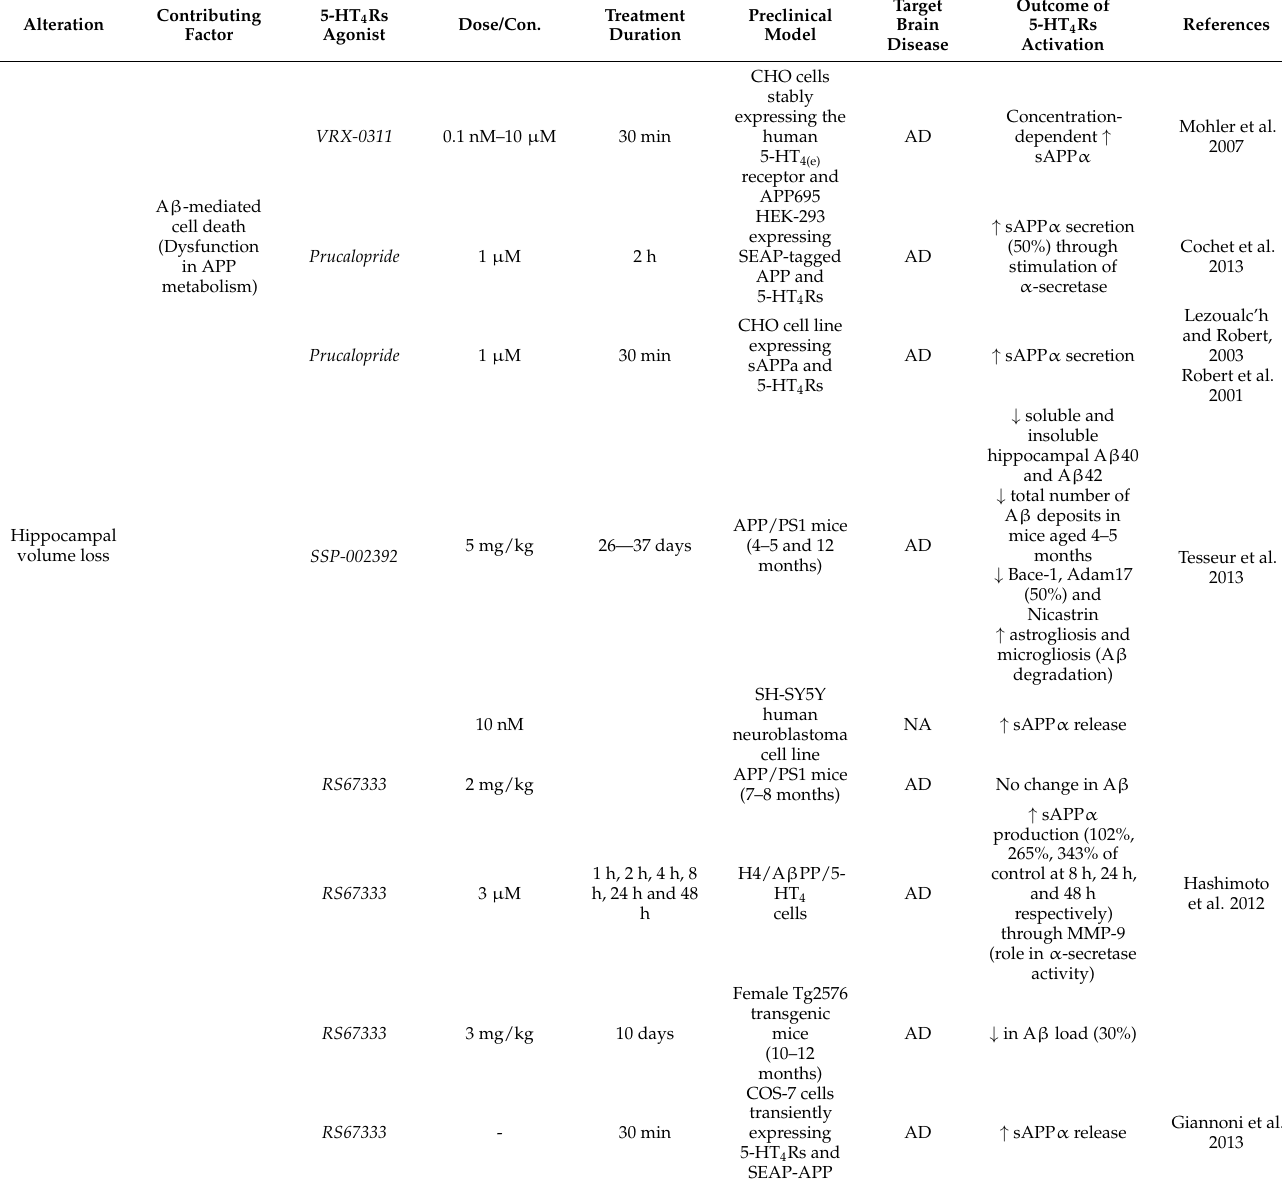
Table 1. Summary of pathological drivers of hippocampal atrophy contributing to memory impairment in AD pathology and beneficial effects of 5-HT 4 Rs ligands. Abbreviations: Dose/Con.: dose/concentration; mg/kg.d: mg/kg per day; ↑ denotes an increase; ↓ denotes a decrease; A β : beta-amyloid peptide; Ach: acetylcholine; AD: Alzheimer’s disease; APP: amyloid precursor protein; APP cleaving enzyme 1; Bace-1: beta-site; cAMP: cyclic adenosine monophosphate; CREB: cAMP response element-binding protein; EC: entorhinal cortex; GABA: gamma-aminobutyric acid; icv: intracerebroventricular; IL-1 β : interleukin 1 beta; IPSPs: inhibitory postsynaptic potentials; MCP-1: monocyte chemoattractant protein-1; MMP-9: matrix metalloproteinase 9; NA: not applicable; pCREB: phosphorylated cAMP response element-binding protein; PD: Parkinson disease; sAPP α : soluble alpha-amyloid precursor protein; 5-HIAA: 5-hydroxyindoleacetic acid; 5-HT: serotonin; 5-HTR: serotonin